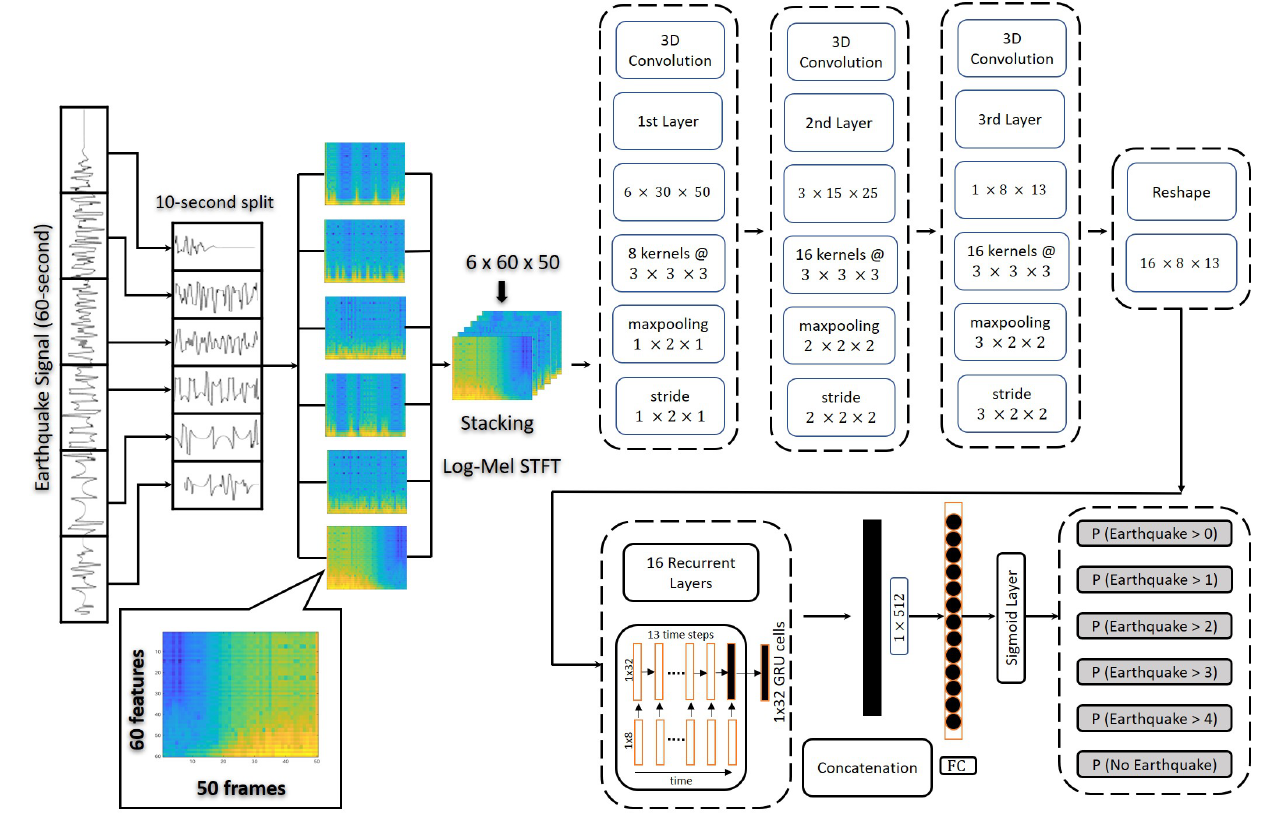
Figure 2. The proposed architecture of 3D-CNN-RNN for earthquake magnitudes categorization. The above design employs a composition of 3 convolutional layers and 16 distinct GRUs for every filter in the subsequent layers. Each feature map from the previous layer is given to 32 GRU cells in the 16 recurrent layers. The sigmoid output layer serves as a final fully connected (FC) layer for categorizing earthquakes. The input consists of a series of 10-s seismic activity